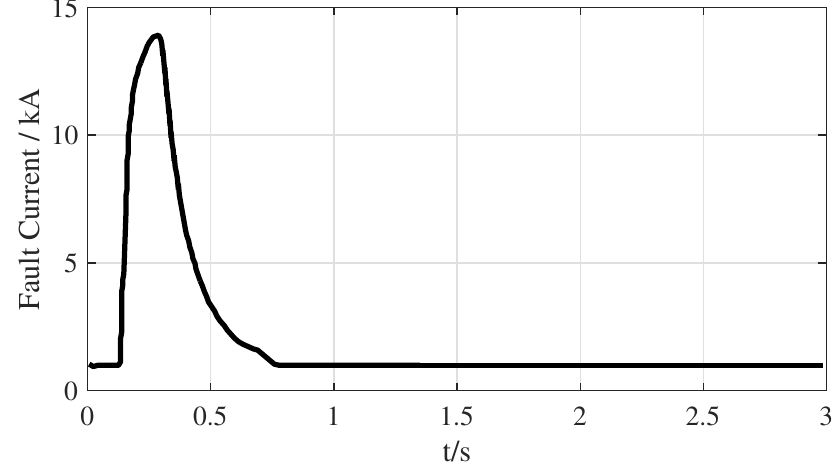
Figure 1. A typical DC pole-to-pole short circuit of MMC-based multi-terminal direct current (MTDC) power